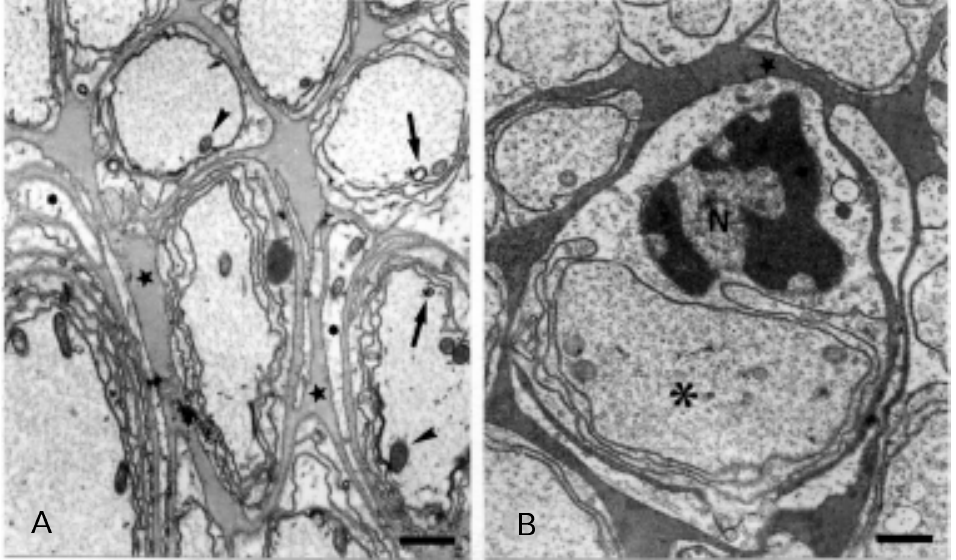
Figure 1 - A , Electron